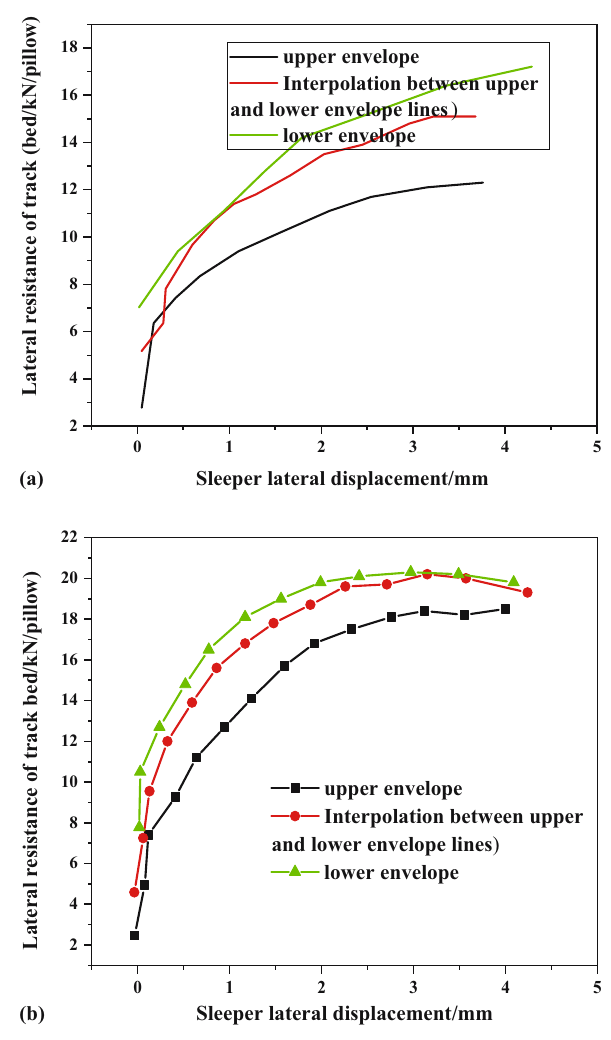
Figure 5: Relationship between transverse and longitudinal resis - tance of track bed and ballast gradation. ( a ) Relationship between transverse resistance of track bed and ballast grading. ( b ) Relationship between longitudinal resistance of track bed and bal - last